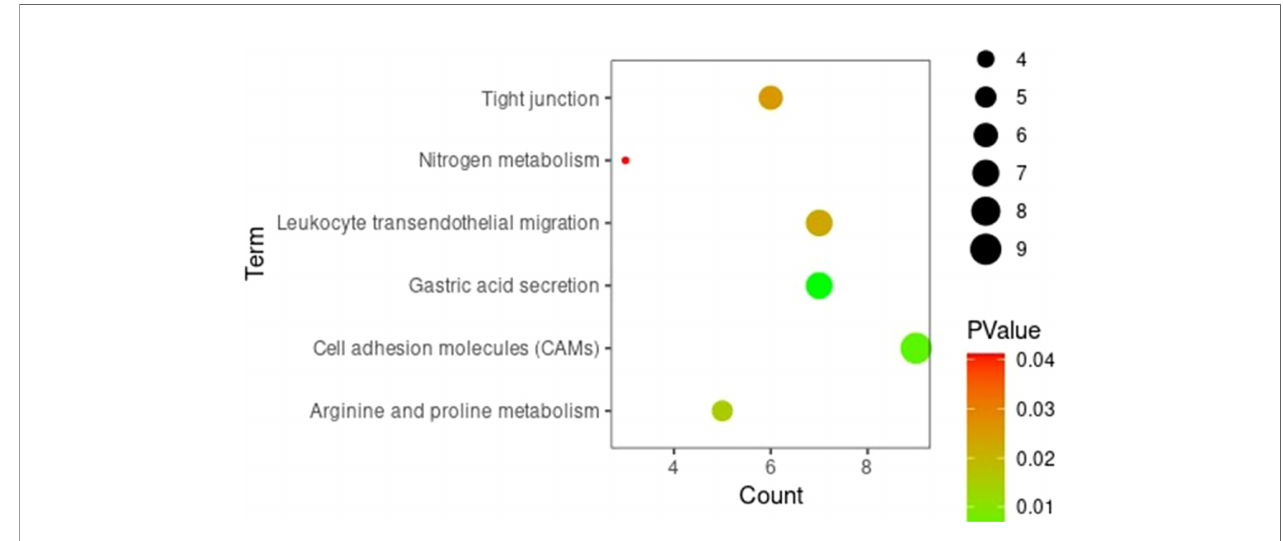
FIGURE 4 | KEGG signaling pathway analysis results of